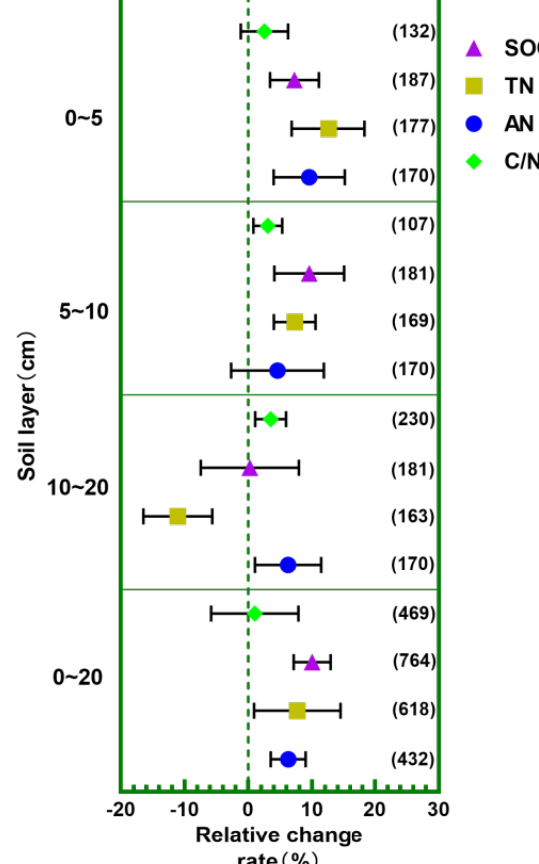
Figure 5. Relative change rates for different soil layers of paddy fields. Description of symbols: AN, soil alkali-hydrolysable nitrogen; TN, soil total nitrogen; SOC, soil organic matter. Numbers in parentheses represent the effect value (lnR).